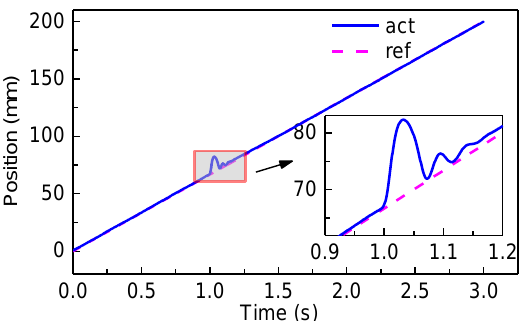
Figure 14. Position tracking under external force disturbance (without ADS).